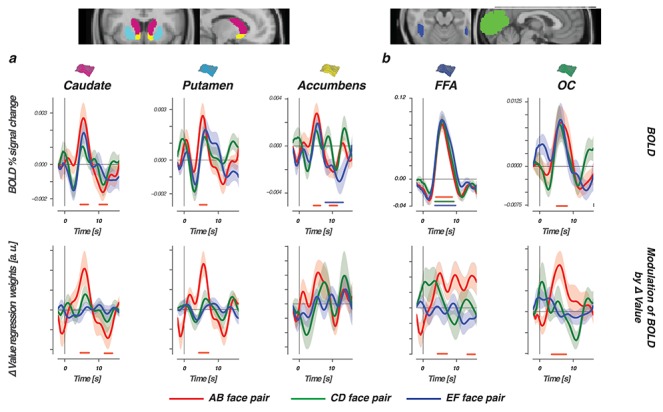
BOLD and the modulation of \documentclass[12pt]{minimal}
\usepackage{amsmath}
\usepackage{wasysym} 
\usepackage{amsfonts} 
\usepackage{amssymb} 
\usepackage{amsbsy}
\usepackage{upgreek}
\usepackage{mathrsfs}
\setlength{\oddsidemargin}{-69pt}
\begin{document}
}{}$\varDelta$\end{document}Value in the learning phase. Top row shows the BOLD signal time course, time-locked to presentations of AB (80:20, red lines), CD (70:30, green lines), and EF (60:40, blue lines) face pairs, for three striatal regions (a) and two perceptual regions (b). Bottom row displays differential modulation by value (\documentclass[12pt]{minimal}
\usepackage{amsmath}
\usepackage{wasysym} 
\usepackage{amsfonts} 
\usepackage{amssymb} 
\usepackage{amsbsy}
\usepackage{upgreek}
\usepackage{mathrsfs}
\setlength{\oddsidemargin}{-69pt}
\begin{document}
}{}$\varDelta$\end{document}Value = modulation \documentclass[12pt]{minimal}
\usepackage{amsmath}
\usepackage{wasysym} 
\usepackage{amsfonts} 
\usepackage{amssymb} 
\usepackage{amsbsy}
\usepackage{upgreek}
\usepackage{mathrsfs}
\setlength{\oddsidemargin}{-69pt}
\begin{document}
}{}${Q}_{\mathrm{chosen}}$\end{document}—modulation \documentclass[12pt]{minimal}
\usepackage{amsmath}
\usepackage{wasysym} 
\usepackage{amsfonts} 
\usepackage{amssymb} 
\usepackage{amsbsy}
\usepackage{upgreek}
\usepackage{mathrsfs}
\setlength{\oddsidemargin}{-69pt}
\begin{document}
}{}${Q}_{\mathrm{unchosen}}$\end{document}). Horizontal lines show the interval in which modulation was significantly stronger for \documentclass[12pt]{minimal}
\usepackage{amsmath}
\usepackage{wasysym} 
\usepackage{amsfonts} 
\usepackage{amssymb} 
\usepackage{amsbsy}
\usepackage{upgreek}
\usepackage{mathrsfs}
\setlength{\oddsidemargin}{-69pt}
\begin{document}
}{}${Q}_{\mathrm{chosen}}$\end{document}. With the presentation of AB faces, BOLD responses in the dorsal striatum (caudate and putamen) and visual regions (FFA and OC) were modulated more by values of the chosen stimulus when compared to values of the unchosen stimulus. Differential AB value modulation was not significant in the ventral striatum (i.e., accumbens). Nor did we observe any differential value modulations with the presentation of the more uncertain CD and EF pairs. Confidence intervals were estimated using bootstrap analysis across participants (\documentclass[12pt]{minimal}
\usepackage{amsmath}
\usepackage{wasysym} 
\usepackage{amsfonts} 
\usepackage{amssymb} 
\usepackage{amsbsy}
\usepackage{upgreek}
\usepackage{mathrsfs}
\setlength{\oddsidemargin}{-69pt}
\begin{document}
}{}$n=1000$\end{document}), where the shaded region represents the standard error of the mean across participants (bootstrapped \documentclass[12pt]{minimal}
\usepackage{amsmath}
\usepackage{wasysym} 
\usepackage{amsfonts} 
\usepackage{amssymb} 
\usepackage{amsbsy}
\usepackage{upgreek}
\usepackage{mathrsfs}
\setlength{\oddsidemargin}{-69pt}
\begin{document}
}{}$68\%$\end{document} confidence interval).